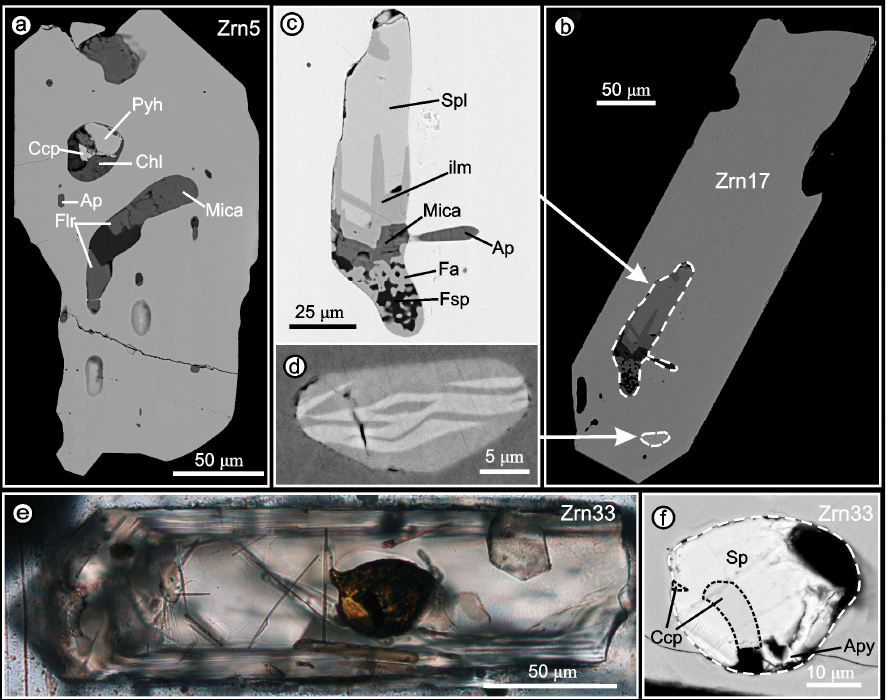
Figure 20. Mineral paragenesis of inclusions in zircon, and mineral features. Abbreviations—see the abbreviations presented in Figure 19. The letters in the white circles represent the following: ( a )—inclusion with big crystals of fluorite; ( b )—zircon with inclusion of Spl-Ilm-Fa-Fsp paragenesis ( c ) and Pyh inclusion ( d ), BSE; ( e )—zircon with sulfide inclusion with a Sp-Ccp composition under transmitted light; and ( f )—inclusion of Sp-Ccp from ( e ) on a larger scale, BSE. Solid-Phase Inclusions